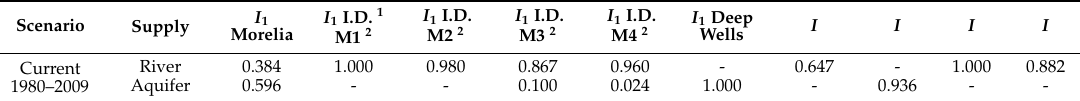
Table 2. Index I i for the current scenario.